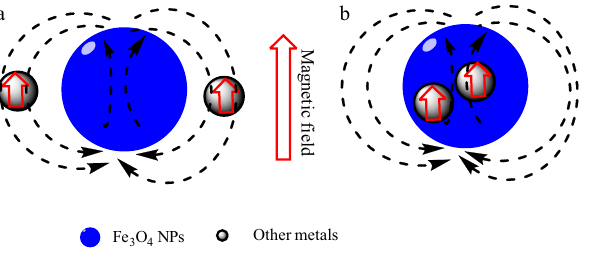
Figure 5: The in fl uence of doping other metals in di ff erent positions on magnetic fi eld strength: ( a ) outer layer; ( b ) inner layer [ 115 ] .